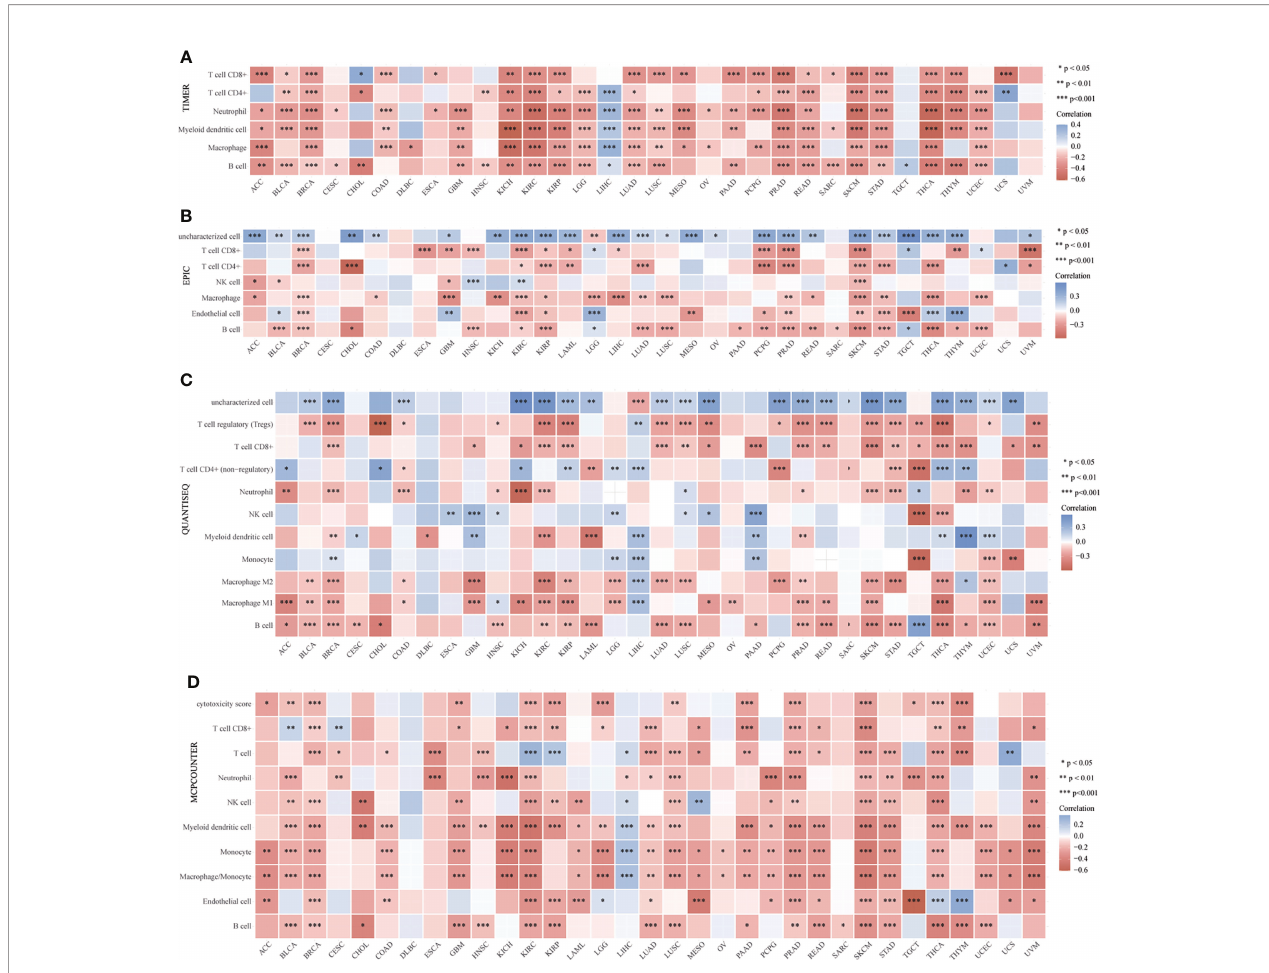
FIGURE 4 | Relationship between CD147 levels and immune in fi ltrates analyzed by the R package immunedeconv in the TME. Immune cell in fi ltration analyzed by the TIMER (A) , EPIC (B) , quanTIseq (C) , MCP-counter (D) , CIBERSORT algorithms. *p < 0.05, **p < 0.01, ***p <